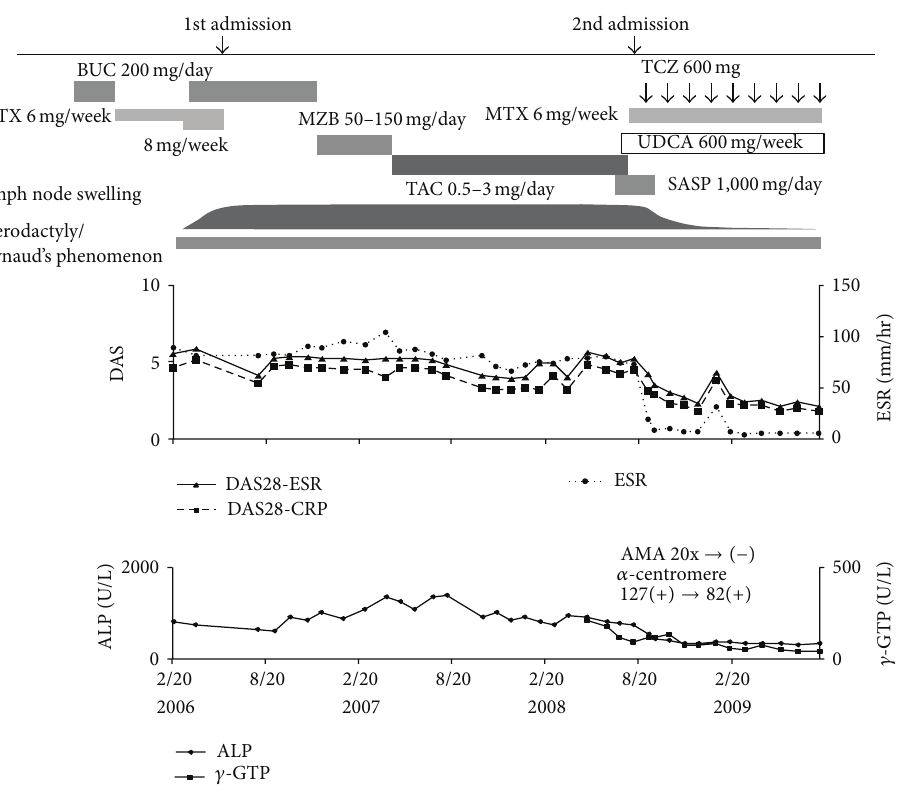
Figure 3: Clinical course and changes in articular manifestations, lymph node swelling, and serum ALP, 𝛾 -GTP concentration. The improvements of articular manifestations, lymph node swelling, and serum ALP, 𝛾 -GTP concentration were closely linked to TCZ